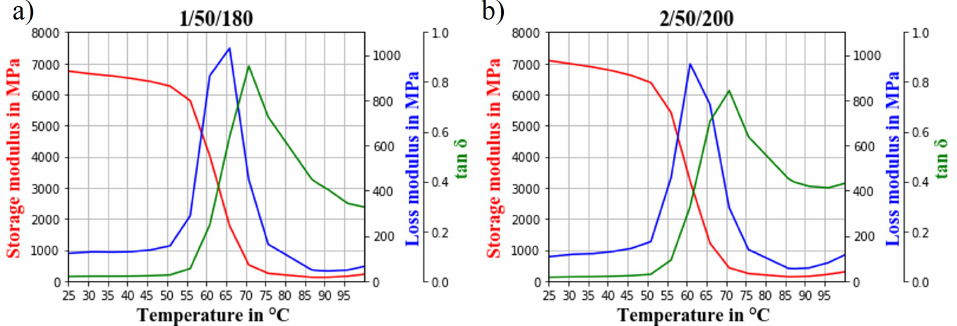
Figure 6. Storage modulus, loss modulus and tan δ obtained from DMA temperature sweep test of ( a ) series 1/50/180 and ( b ) series